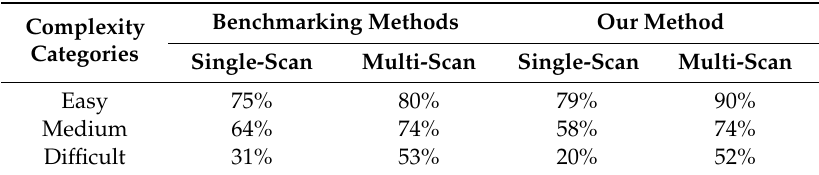
Table 4. Comparison of the mean accuracy of stem detection between TLS benchmarking methods and our method.